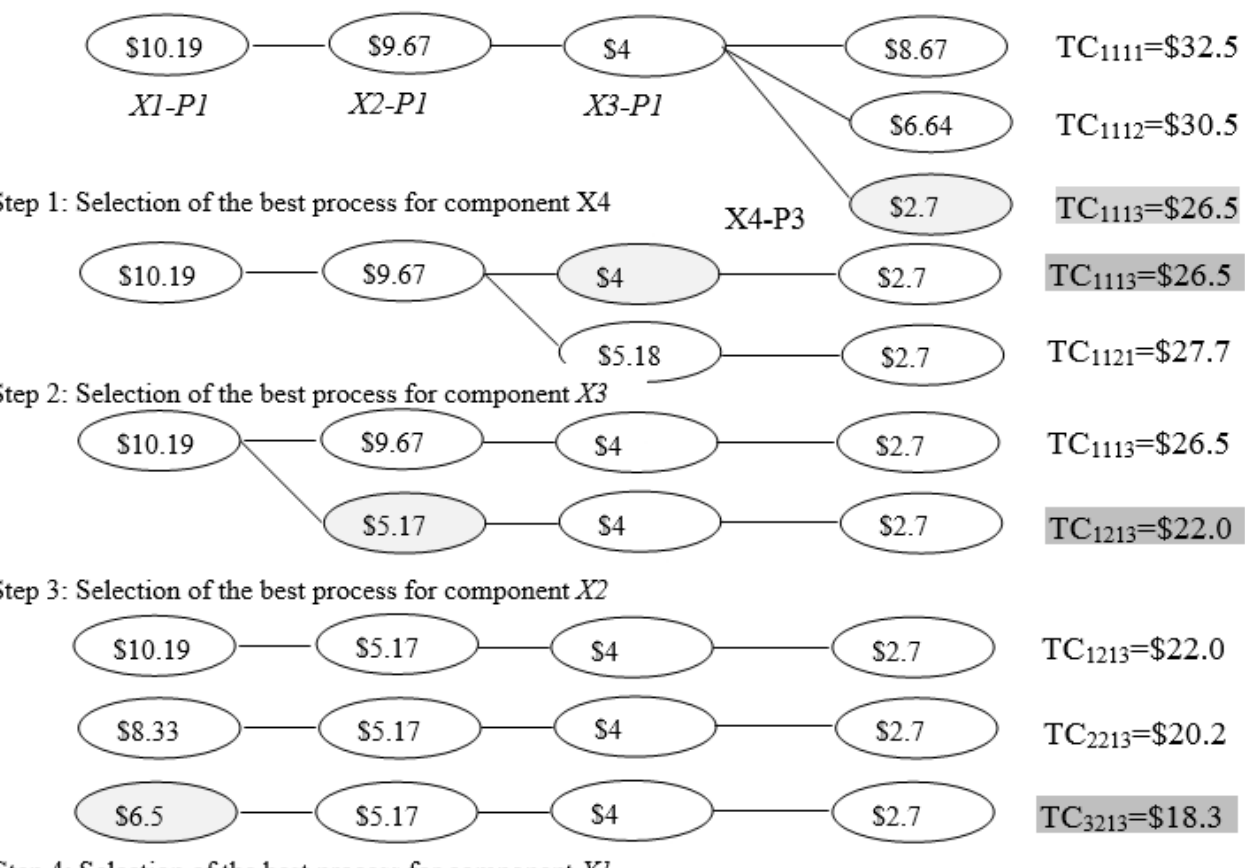
Figure 2. Univariate search method to select the best process for each component. X1-P1 indicates that X1 component is produced by the P1 process; TC1113 = $26.56 indicates that components X1, X2, X3, and X4 are manufactured using processes P1, P1, P1 , and P3 , respectively, and the total cost to manufacture the same will be $26.56.